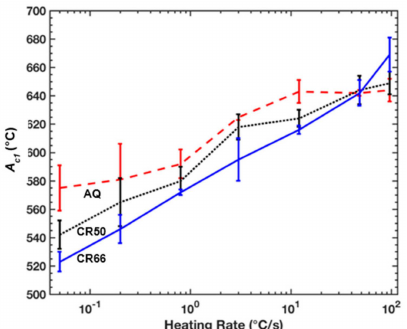
Figure 4. A c1 temperatures assessed via dilatometry for each condition and heating rate.